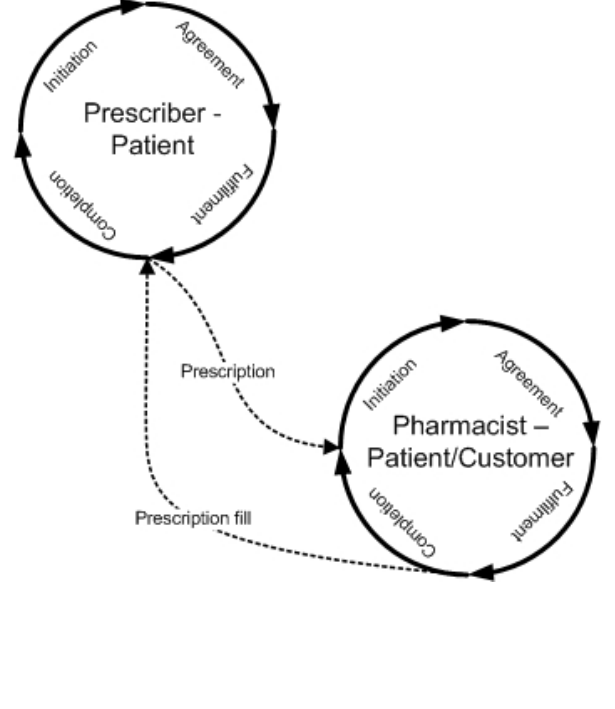
Figure 5. ePrescribing process seen as a process of initiation, agreement, fulfillment, and completion in two exchange situations: Prescriber – Patient and Pharmacy –